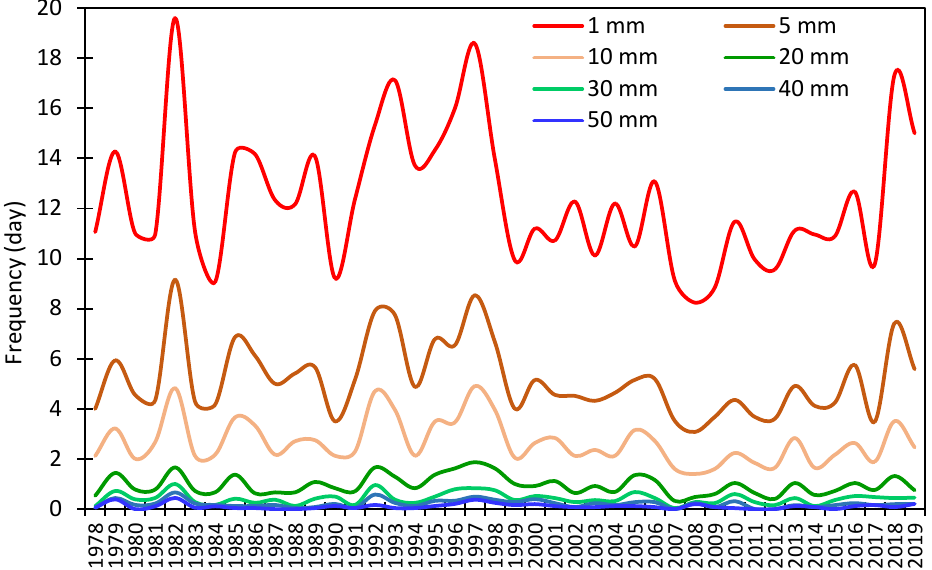
Figure 9. Extreme rainfall time sequence of event frequency for different thresholds in Saudi Arabia for the period 1978–2019.